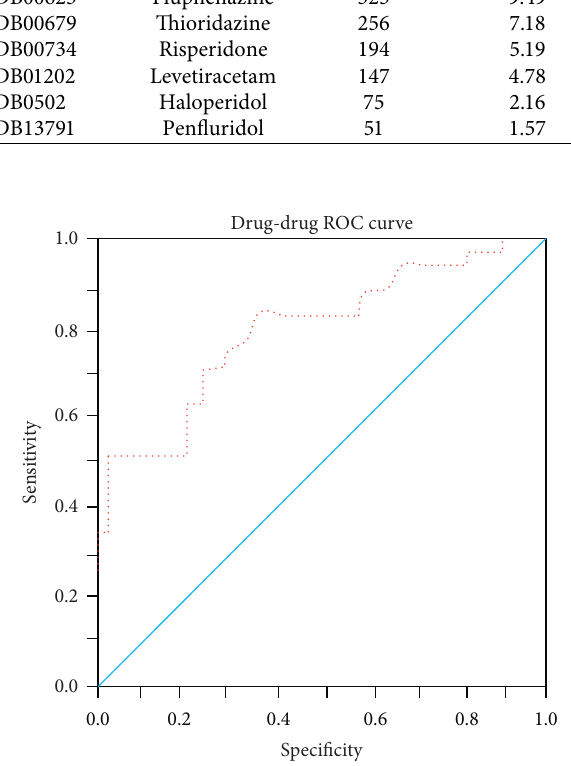
Figure 10: ROC curve performance evaluation of all the results of the drug-drug treatment for